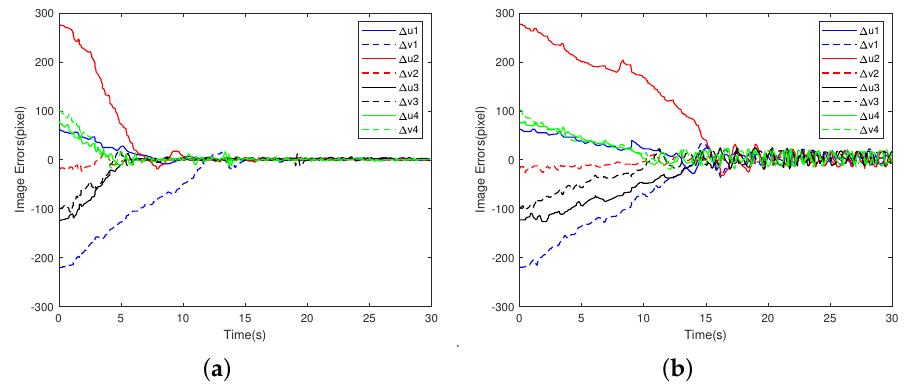
Figure 10. Image errors of comparative simulations with time-varying external disturbances for the 2-DOF robot manipulator. ( a ) Image errors in Case 3 . ( b ) Image errors in Case